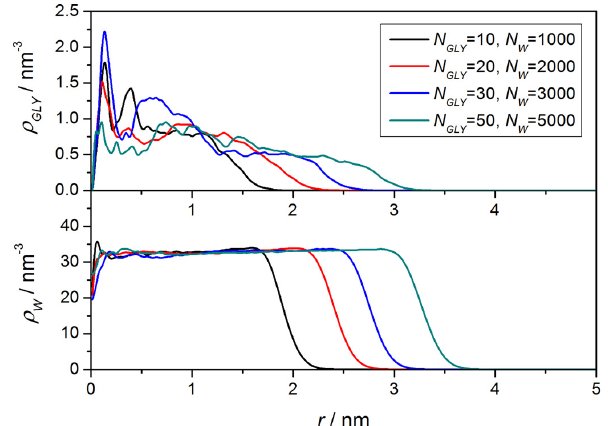
Fig. 3. Radial number densities of glycine and water molecules in systems 7–10.